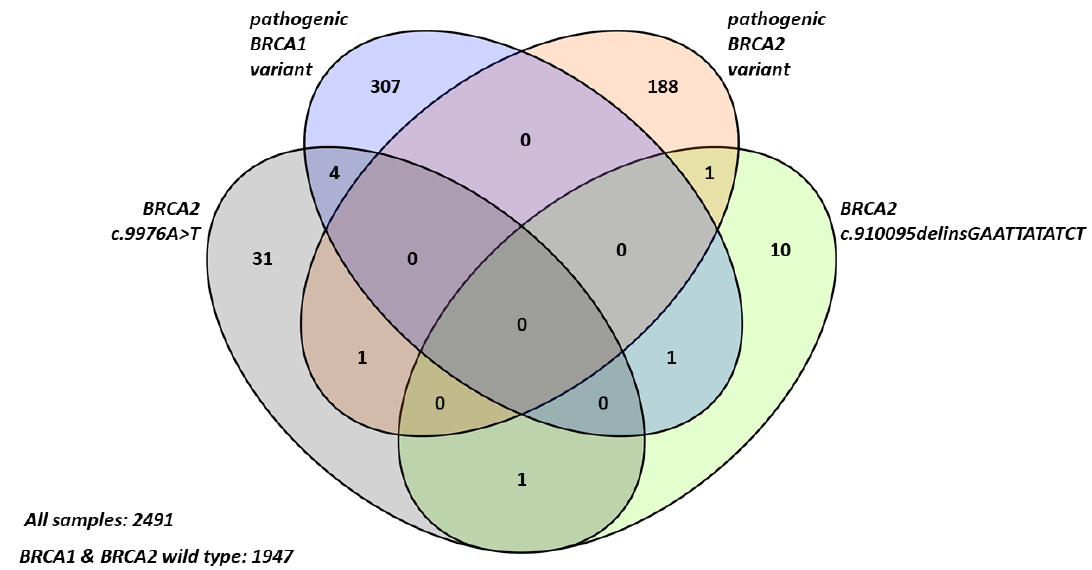
Figure 1. Numbers of BRCA1 and BRCA2 variants identified in our cohort. Table 1. Patient characteristics harboring BRCA2 C-terminal variants (LRG_292t1:c.9976A>T, p.(Lys3326Ter) and